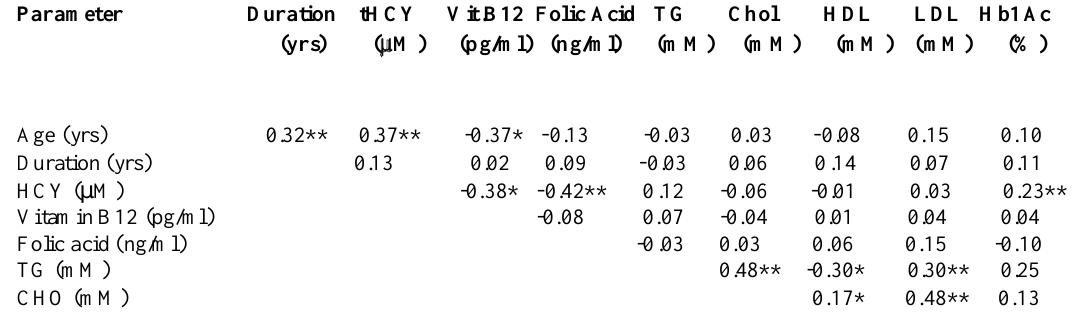
Table 2.: Correlations of homocysteine, vitaminB12 and folate with demographic and other biochemical para- meters. Correlations (r-value) were assessed by Spearman rank correlation. *p < 0.05; **p <